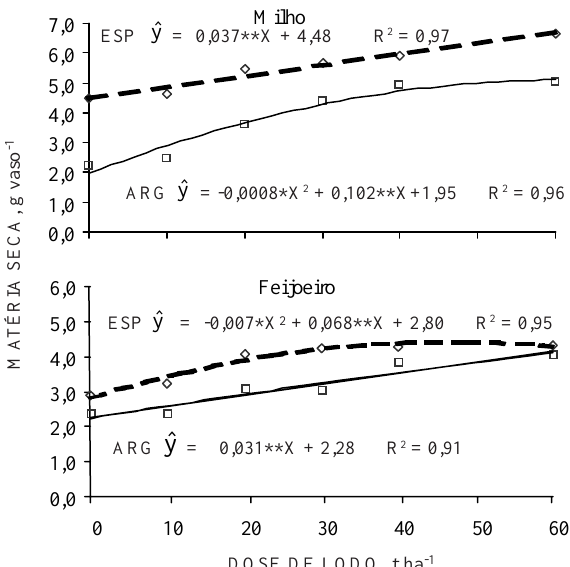
Figura 1. Produção de matéria seca de plantas de milho e feijoeiro em dois solos (Espodossolo – ESP e Argissolo – ARG) tratados com doses crescentes de lodo de